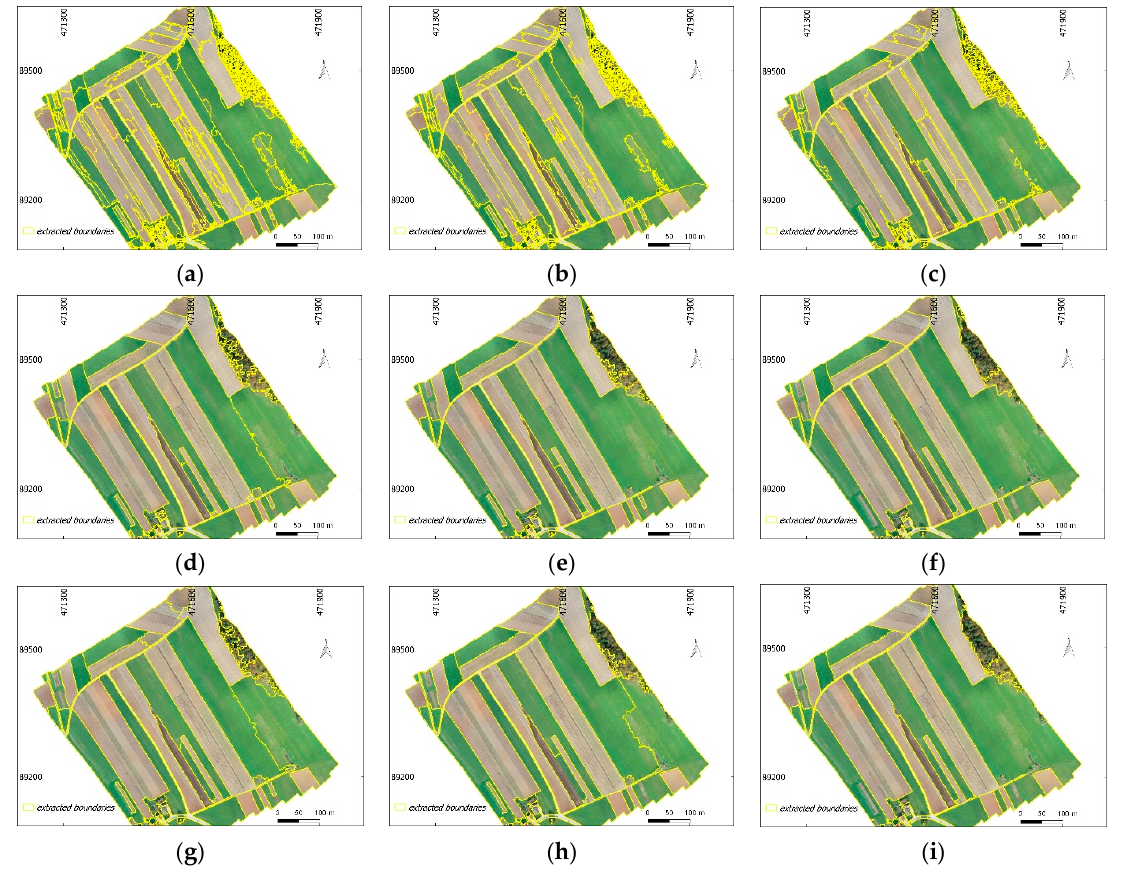
Figure 5. ( a – i ) Examples of extracted boundary maps. ( a – c ) GSD 25 cm; ( d – f ) GSD 50 cm, and ( g – i ) GSD 100 cm. ( a , d , g ) Extracted objects at scale 70 and merge 99. ( b , e , h ) Extracted objects at scale 75 and merge 99. ( c , f , i ) Extracted objects at scale 80 and merge 99.